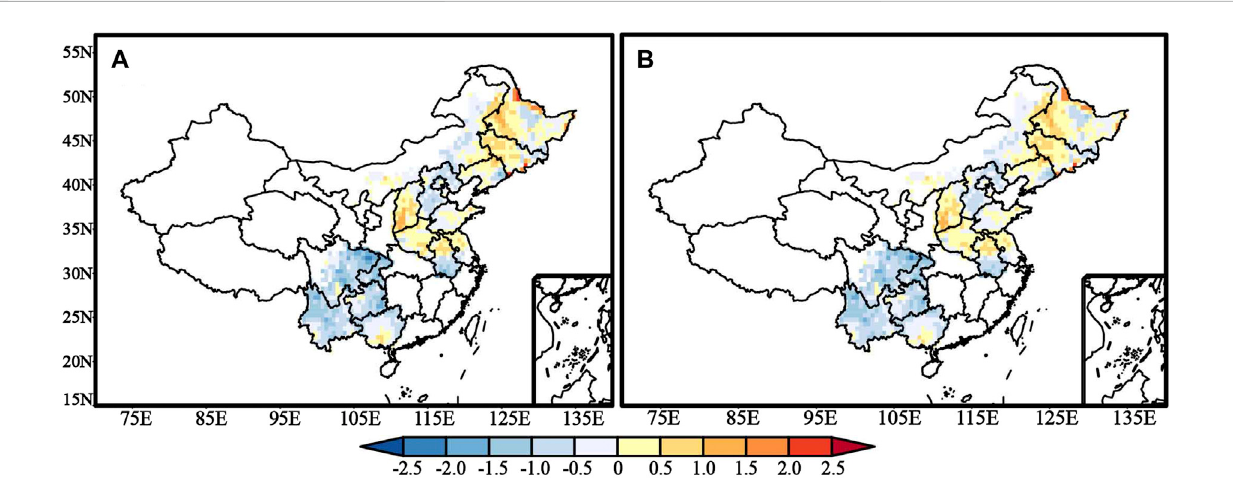
FIGURE 3 The 2010-2016 annual average observed and predicted yield anomalies. (A) , The average yield anomalies estimated from a linear trend of observed annual yields in 2010 – 2016. (B) , Same as in a, but driven by VPD and soil moisture in the maize root